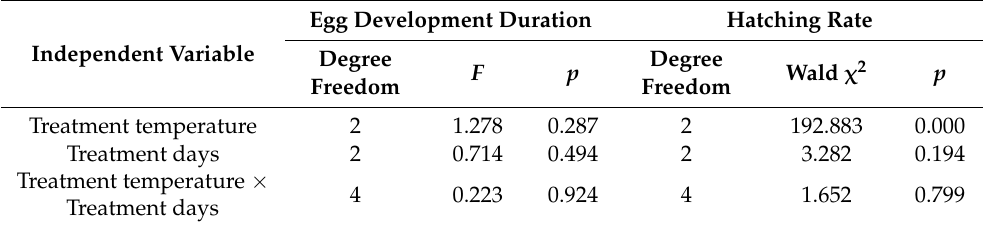
Table 1. Results of general linear model (GLM), generalized linear model for effects of treatment temperature, treatment days and their interaction effect on the egg development duration, the hatching rate of CPBs.